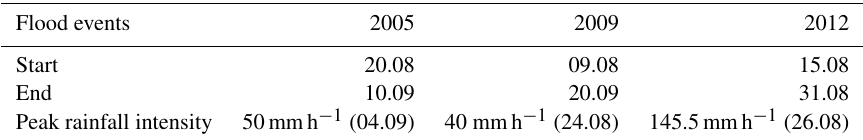
Figure 1. Location of the study area. The insert on the right corner locates our study area in the city of Dakar in Senegal. The central map represents our study area Yeumbeul North without the retention basins that were constructed after the 2012 flood. The 82 neighbourhoods are designated by a number from 1 to 82. The corresponding names are provided in the Supplement Table S1. Table 1. The beginning and the end of the three flood events according to the Emergency Events Database (EM-DAT), as well as the rainfall intensity peak of each event at the Dakar-Yoff station from the National Agency for Civil Aviation and Meteorology (ANACIM) database in